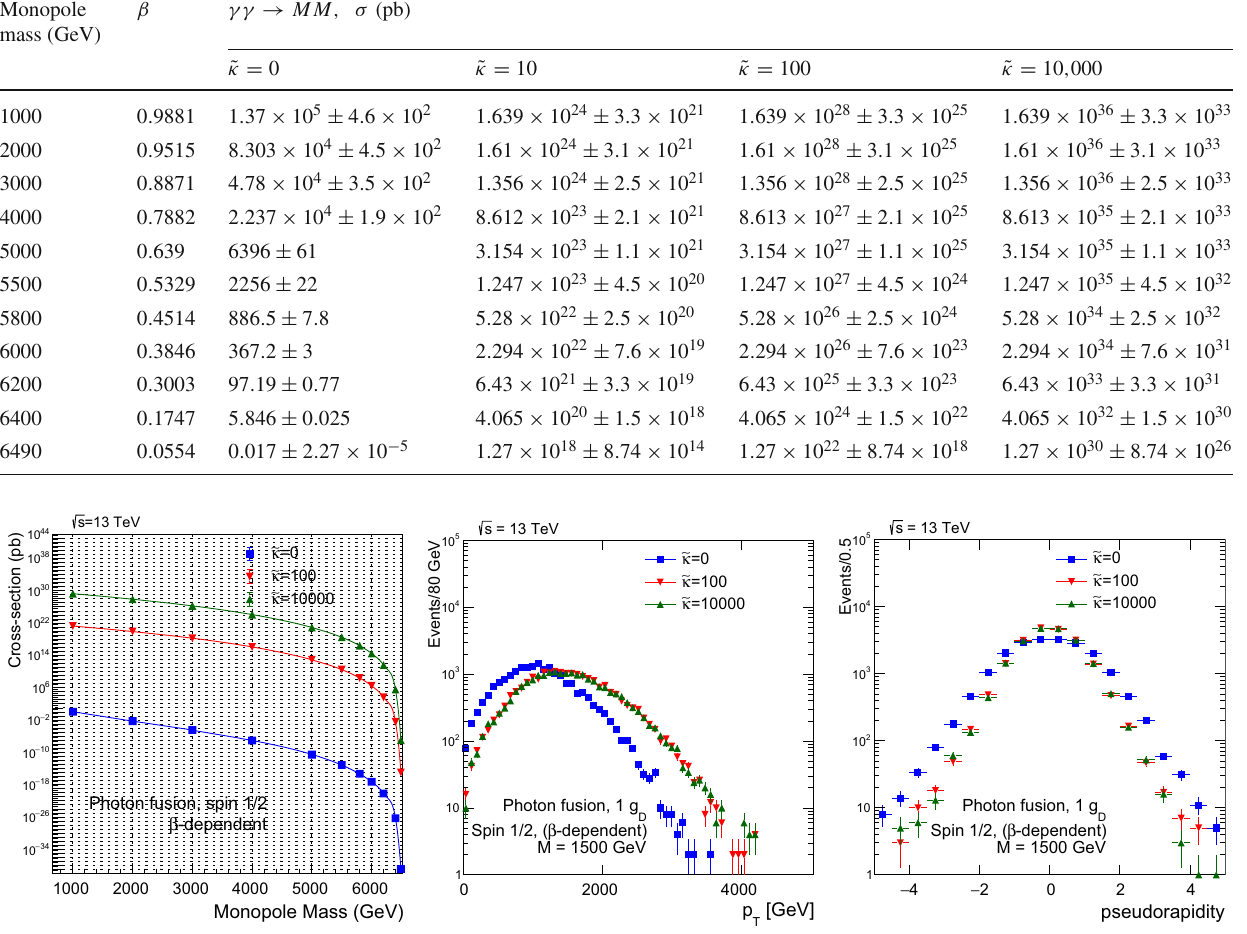
Table 3 Photon-fusion production cross sections at parameter